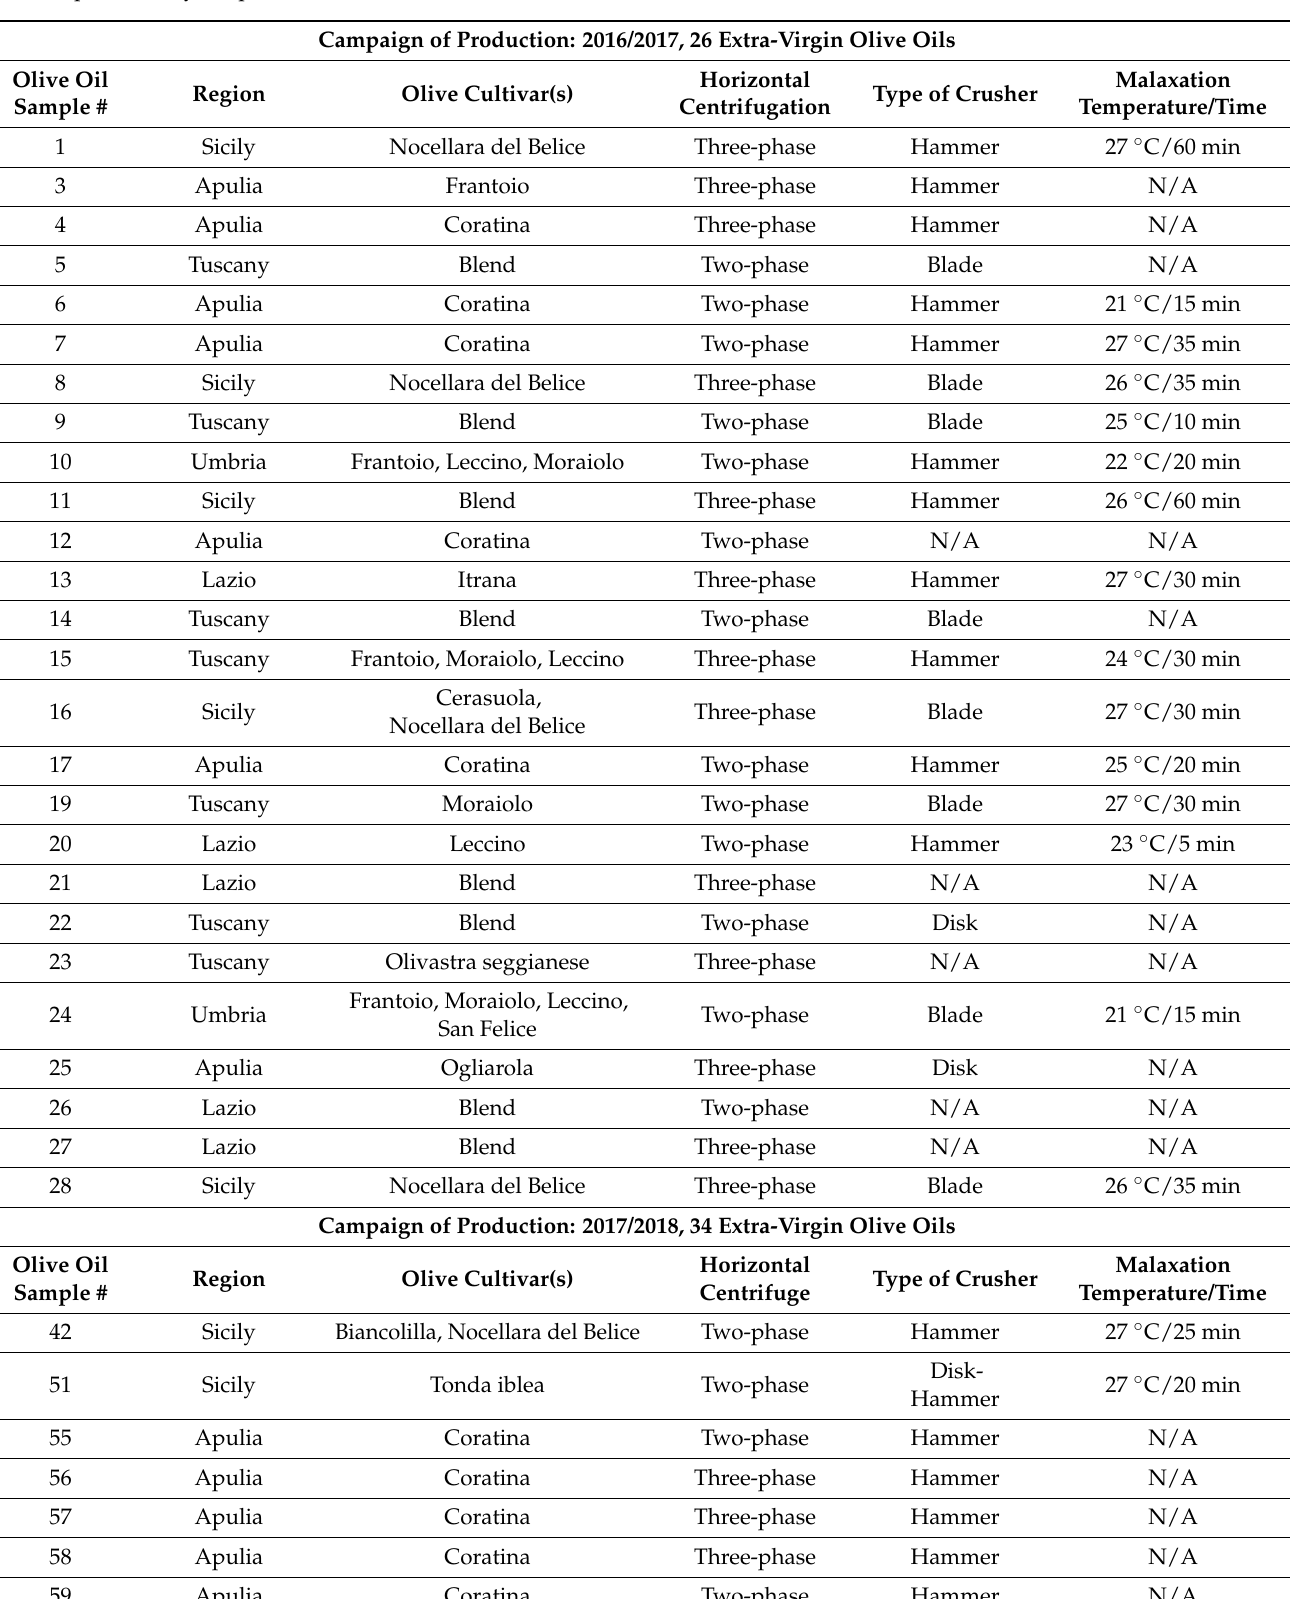
Table 1. Summary of production-related information provided by producers for the 60 Italian olive oils analyzed in this work. Sample numeration is the same adopted in the context of VIOLIN research project. N/A = Not Available (information not provided by the